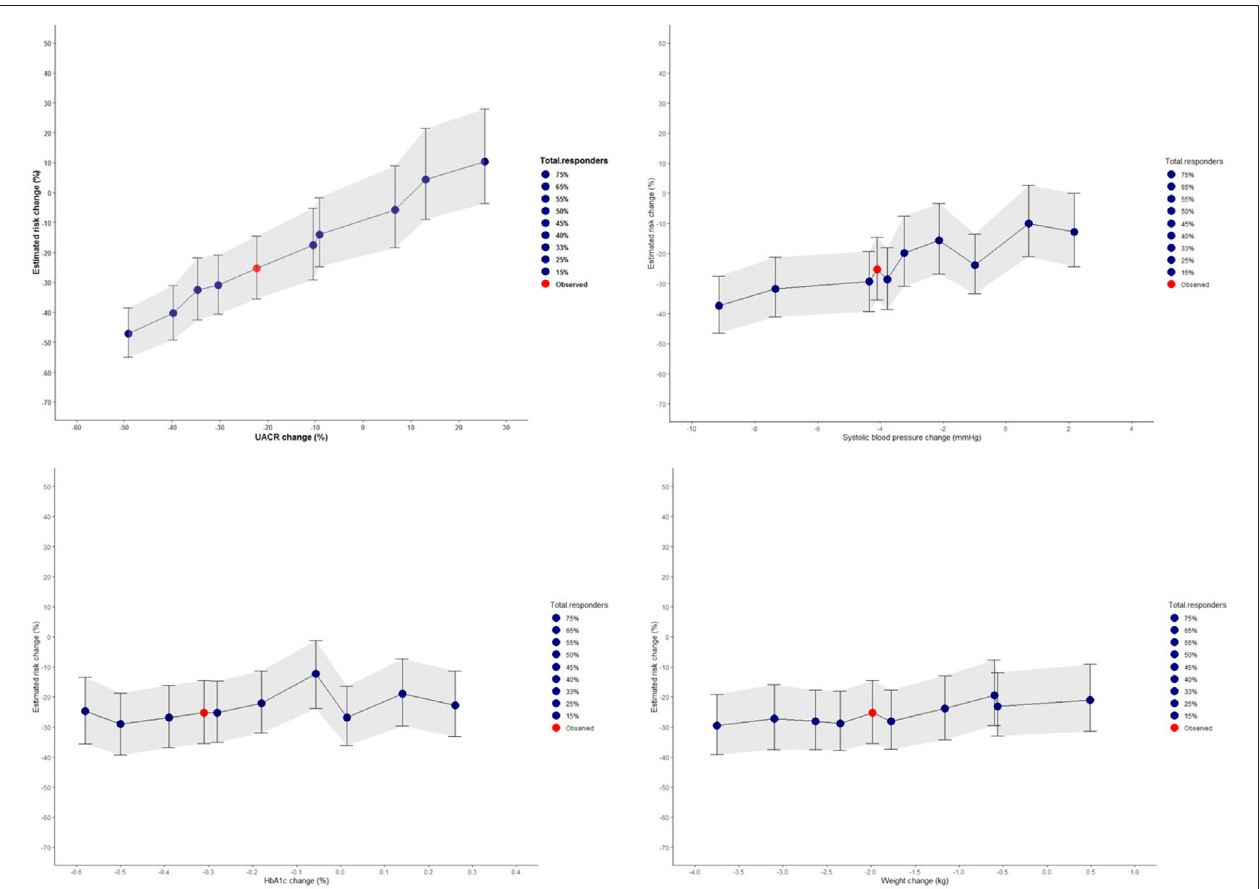
FIGURE 6 | Simulated risk marker changes and the effect on the composite kidney and cardiovascular death outcomes for the prospective EMPA-KIDNEY trial based on the selected EMPA-REG OUTCOME trial population. The shaded area indicates the 95% con fi dence intervals for the simulated risk marker changes. Risk predictionwasestimated fromshort-term riskmarkerchangesintheEMPA-KIDNEYpopulation(N (cid:1) 1222)chosenfromtheEMPA-REGOUTCOMEtrial,andsimulated values for UACR, systolic blood pressure, HbA1c, and body weight. The red dot indicates the PRE score predicted risk change in the EMPA-KIDNEY trial without enrichment with responders. The blue dots represent changes observed in the different proportion of responders and non-responders for each risk marker. HbA1c, glycated hemoglobin; UACR, urinary-albumin-to-creatinine ratio.